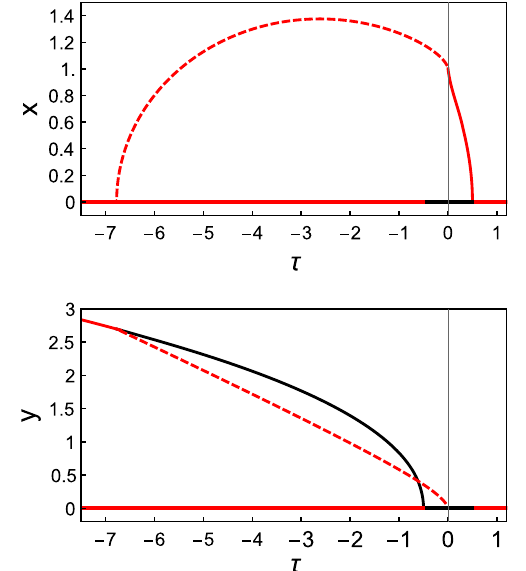
FIG. 12. Spatial coordinates ð x; y Þ of the dynamical fixed points lying in one quadrant of the transverse plane are shown as functions of the parameter τ , illustrating the fixed point bifurcations discussed in Sec. VI A. Each figure must be extended by symmetry to x < 0 or y < 0 . (Black) Stable fixed point. (Red) Unstable fixed point. Compare the summary in Table